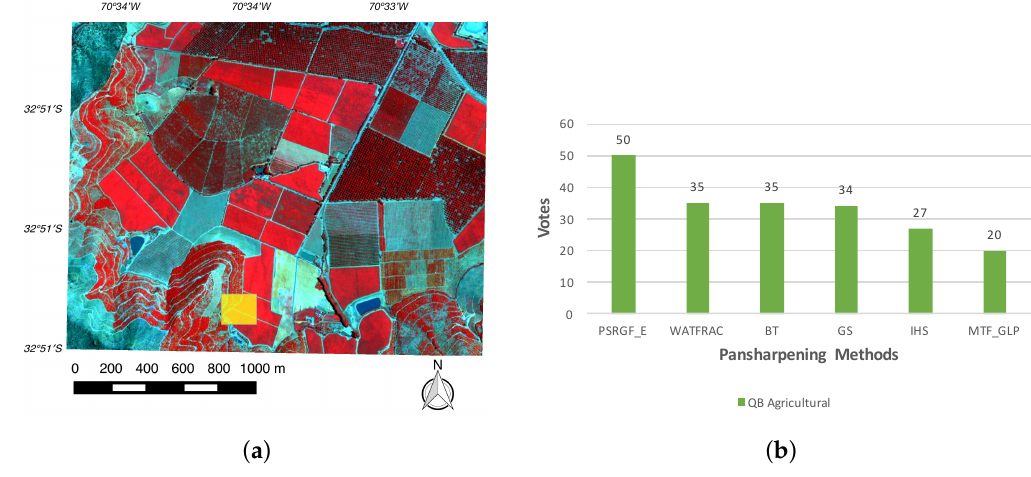
Figure 8. ( a ) QB Agricultural false color composition (NIR-red-green), and the specific analysis site (yellow box); ( b ) ranking of the methods, using BC, sorted by